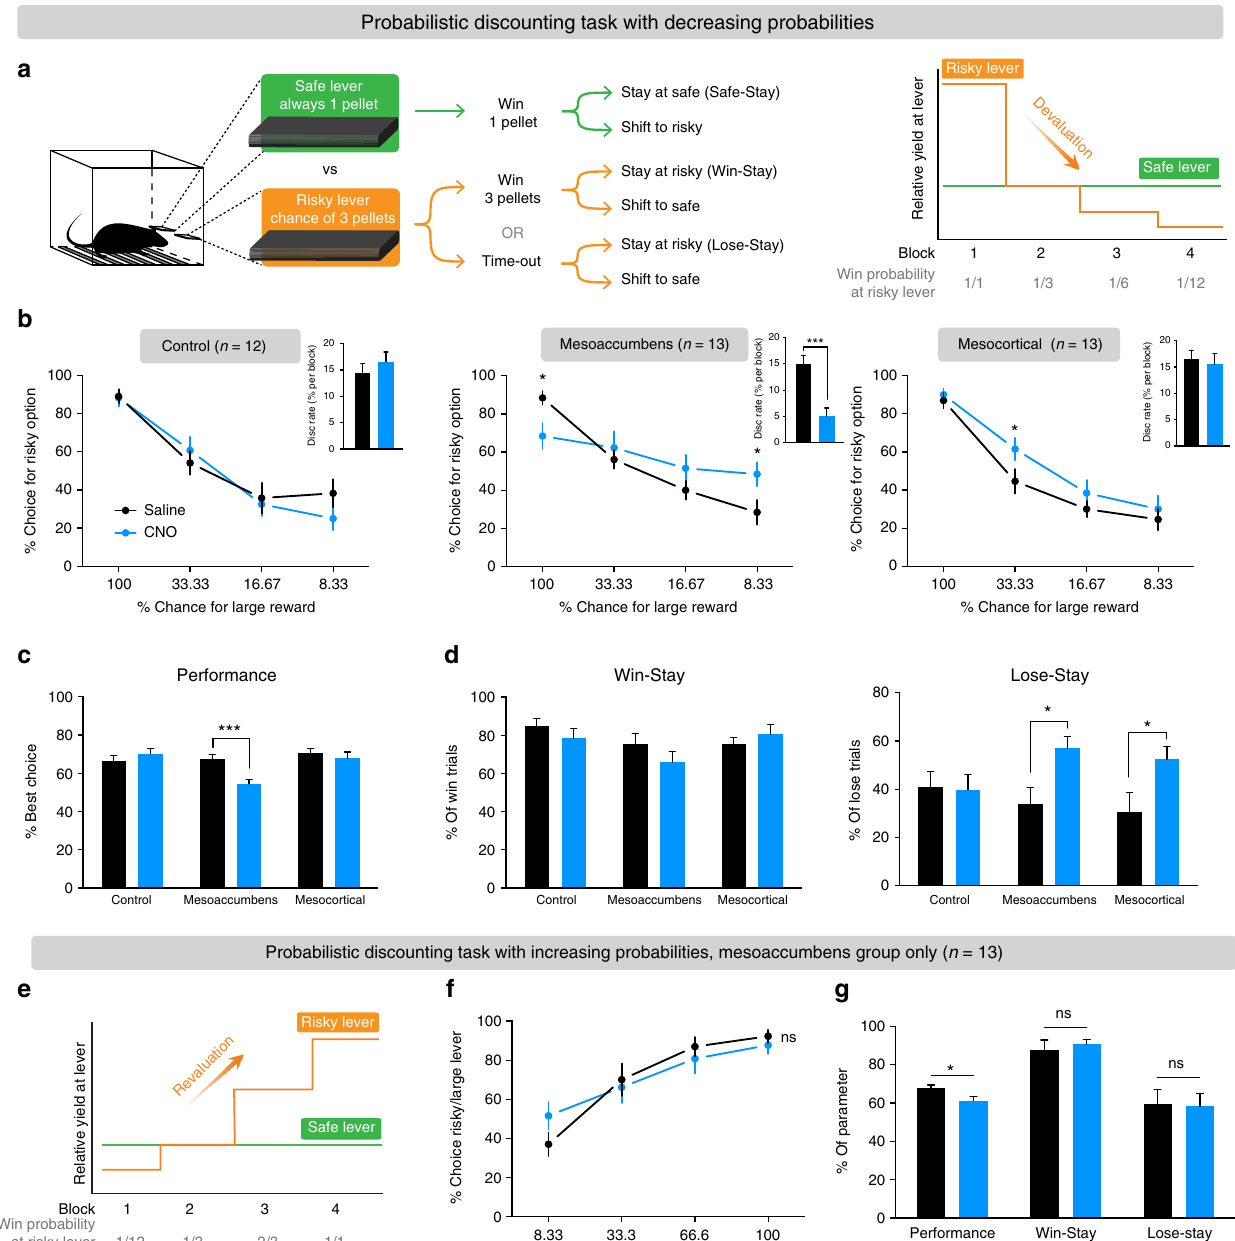
Fig. 4 Chemogenetic activation of the mesoaccumbens and the mesocortical pathway alters probabilistic discounting. a Task design. b Discounting curves for individual groups. (Left panel) Sham control group (saline vs CNO; Sidak ’ s test, p > 0.1 for all blocks). (Middle panel) During mesoaccumbens hyperactivity, animals have a smaller preference for the risky lever in the fi rst block (Sidak ’ s test, p = 0.0468), a larger preference for the risky lever in the last block ( p = 0.0468; blocks 2 and 3 both p > 0.1), and a signi fi cantly diminished discounting rate (inset, p = 0.0002). (Right panel) Mesocortical activation increased choice for the risky lever in the second block (Sidak ’ s test in block 2, p = 0.0247; blocks 1, 3, and 4, all p > 0.1). Asterisks in discounting curves indicate signi fi cant difference between saline and CNO treatment. Insets display the average steepness of the discounting curve (statistical comparison with Sidak ’ s test). c Mesoaccumbens activation reduces the percentage optimal choices in the probabilistic discounting task (i.e., % best choice in blocks 1, 3, and 4; two-way ANOVA; effect of CNO, p = 0.0331; group×CNO interaction, p = 0.0016; post-hoc Sidak ’ s test, p = 0.5082 for control group, p = 0.0004 for mesoaccumbens group, p = 0.7533 for mesocortical group). d Chemogenetic activation of the mesoaccumbens or mesocortical pathway had no effect on win-stay behavior (two-way ANOVA; effect of CNO, p = 0.36; group×CNO effect, p = 0.26), but did increase lose-stay behavior (two-way repeated ANOVA; effect of CNO, p = 0.0026; group×CNO effect, p = 0.0622; post-hoc Sidak ’ s test, p = 0.9988, p = 0.0177 and p = 0.0203 for control, mesoaccumbens, and mesocortical groups, respectively). e Task design of the probabilistic discounting task with increasing probabilities. f Mesoaccumbens activation did not affect the discounting curve (Sidak ’ s test in every block, p > 0.1). g Mesoaccumbens activation decreased performance on the task (paired t -test, p = 0.0143), but not win-stay (paired t -test, p = 0.32) or lose-stay behavior (paired t -test, p = 0.85). Data are shown as mean ± standard error of the mean; ns not signi fi cant, * p < 0.05, *** p <